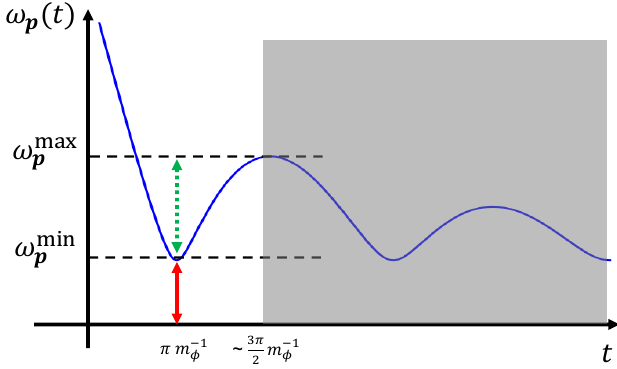
Figure 5 . A schematic figure of the effective frequency of χ particle ω p ( t ) . The full effective frequency shows a dumped oscillation, while we focus only around the first minimum m φ t ∼ π (i.e., neglect the shaded region), where the dominant number of parent χ particles are presumably produced. The perturbative decay | χ i → | ψψ i is possible if ω min Ω k +Ω k + p is within the range indicated by a green dotted line). If Ω k +Ω k + p < ω min is within the range indicated by a red line), the kinematically-forbidden ψ production